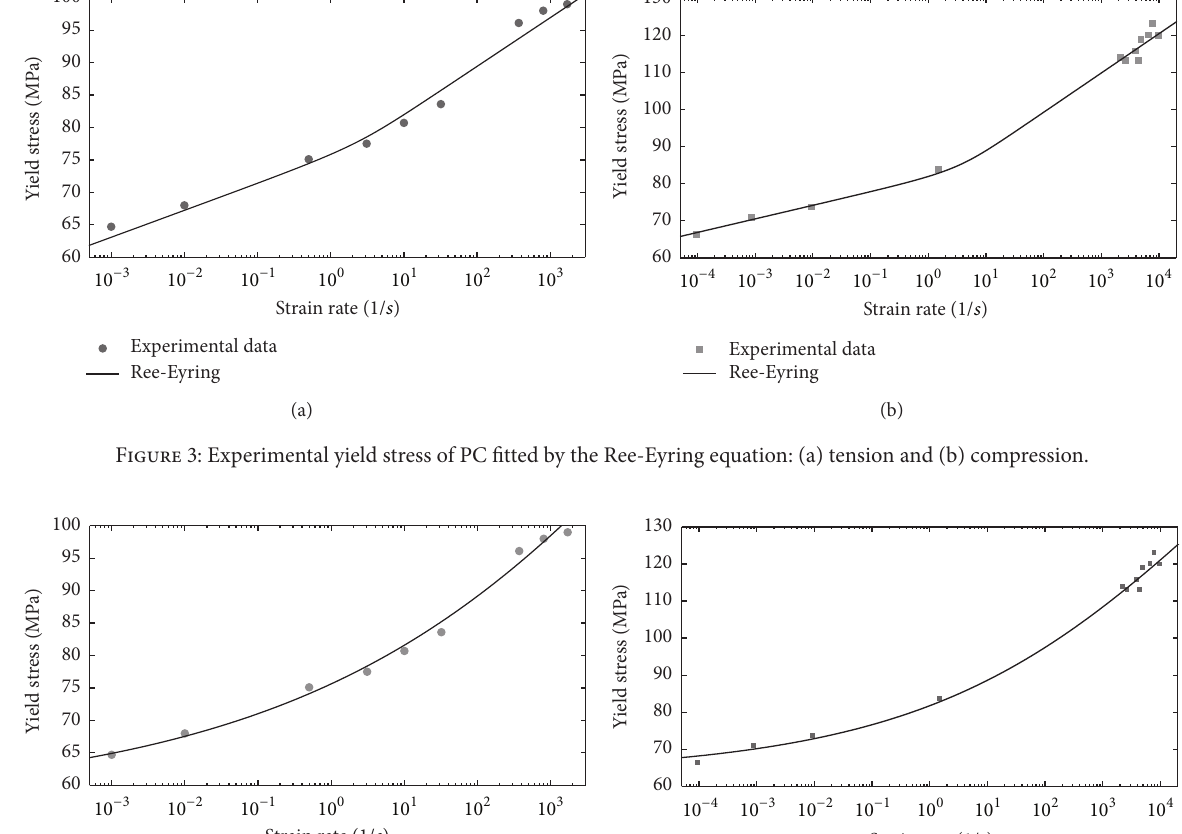
Table3:Materialconstants,error,andcorrelationofthecooperative